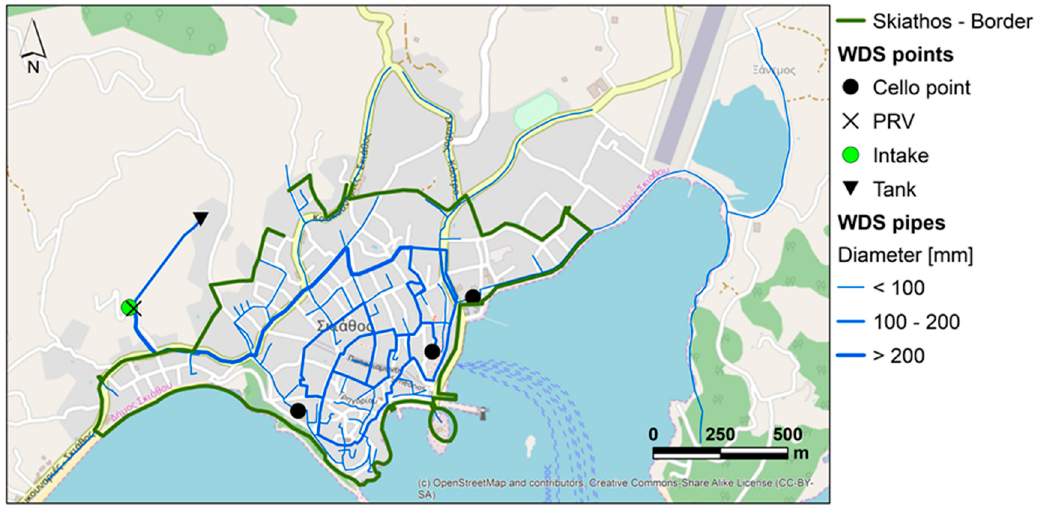
Figure 3. Skiathos water distribution system (WDS).